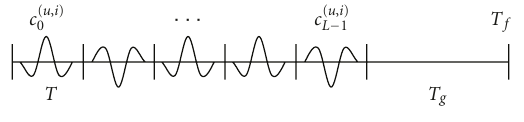
Figure 2: Frame format for user u and code i